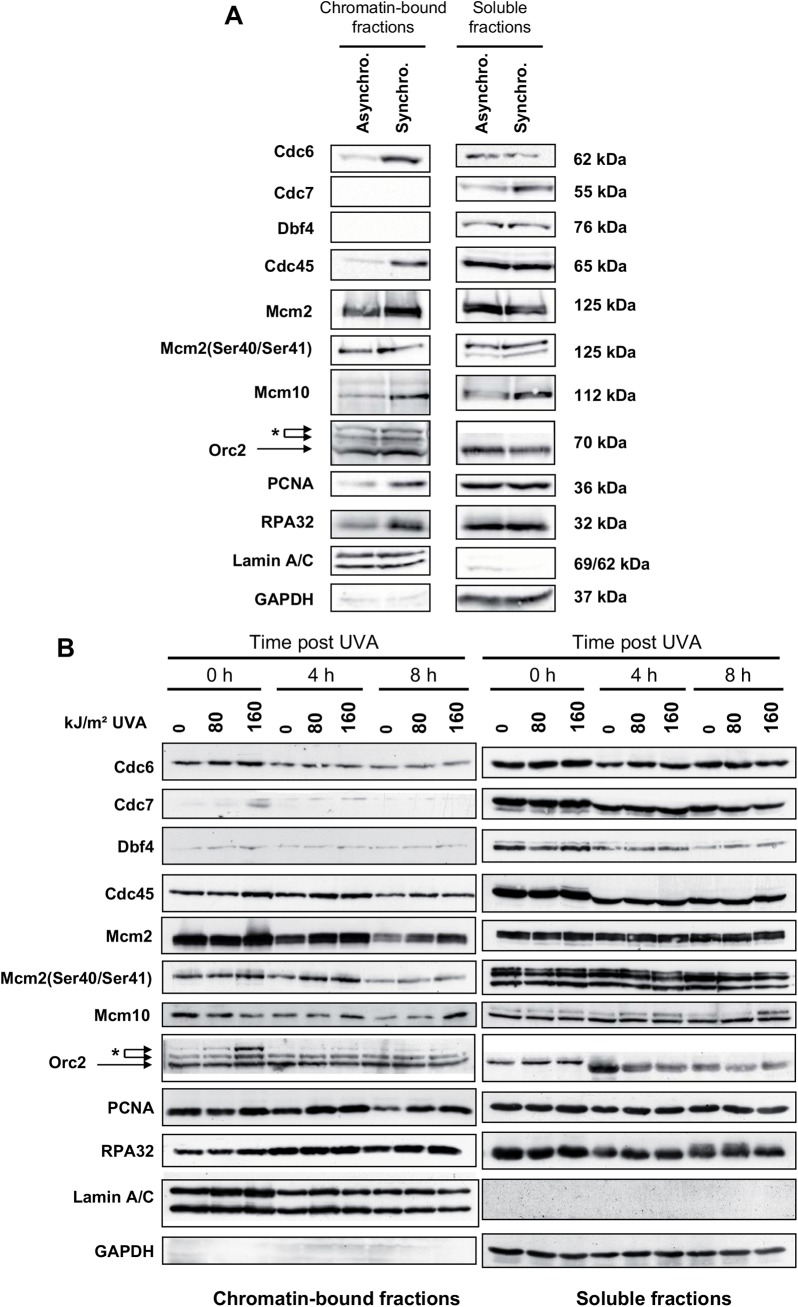
No relocalization or post-translational modifications of some components of the replication machinery after UVA radiation.Asynchronous MRC5Vi cells or synchronized in early S-phase (condition S0R, see Material and Methods) are untreated or exposed to 80 and 160 kJ/m2 of UVA radiation. (A) Subcellular localization of Cdc6, Cdc7, Dbf4, Cdc45, Mcm2, Mcm10, Orc2, PCNA, RPA32 in asynchronous cells (Asyncro.) or cells synchronized in early S-phase (Synchro.). (B) The fractions of chromatin-bound proteins and total soluble proteins were recovered at various time points post UVA. The expression levels of Cdc6, Cdc7, Dbf4, Cdc45, Mcm2, p-Mcm2(Ser40/41), Mcm10, Orc2, PCNA, and RPA32 were detected by Western blotting in denaturing and reducing conditions. Lamin A/C and GAPDH were used as loading control for the chromatin-bound and soluble fractions, respectively. The apparent molecular weight of each protein is indicated on the right side of each blot (panel 7A). The stars (*) indicate the position of the non specific bands detected by Orc2 antibody (H-300, SCBT).